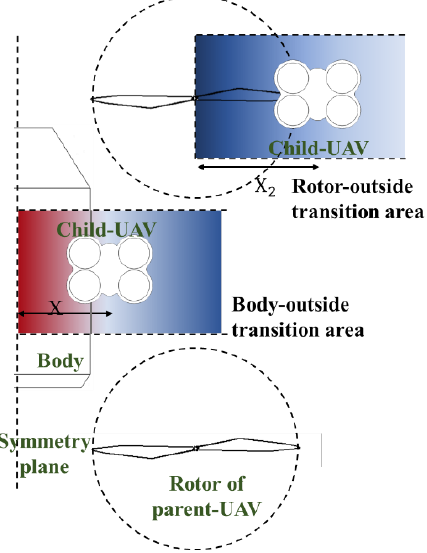
Figure 19. Schematic diagram of the influence extent above a rotor.